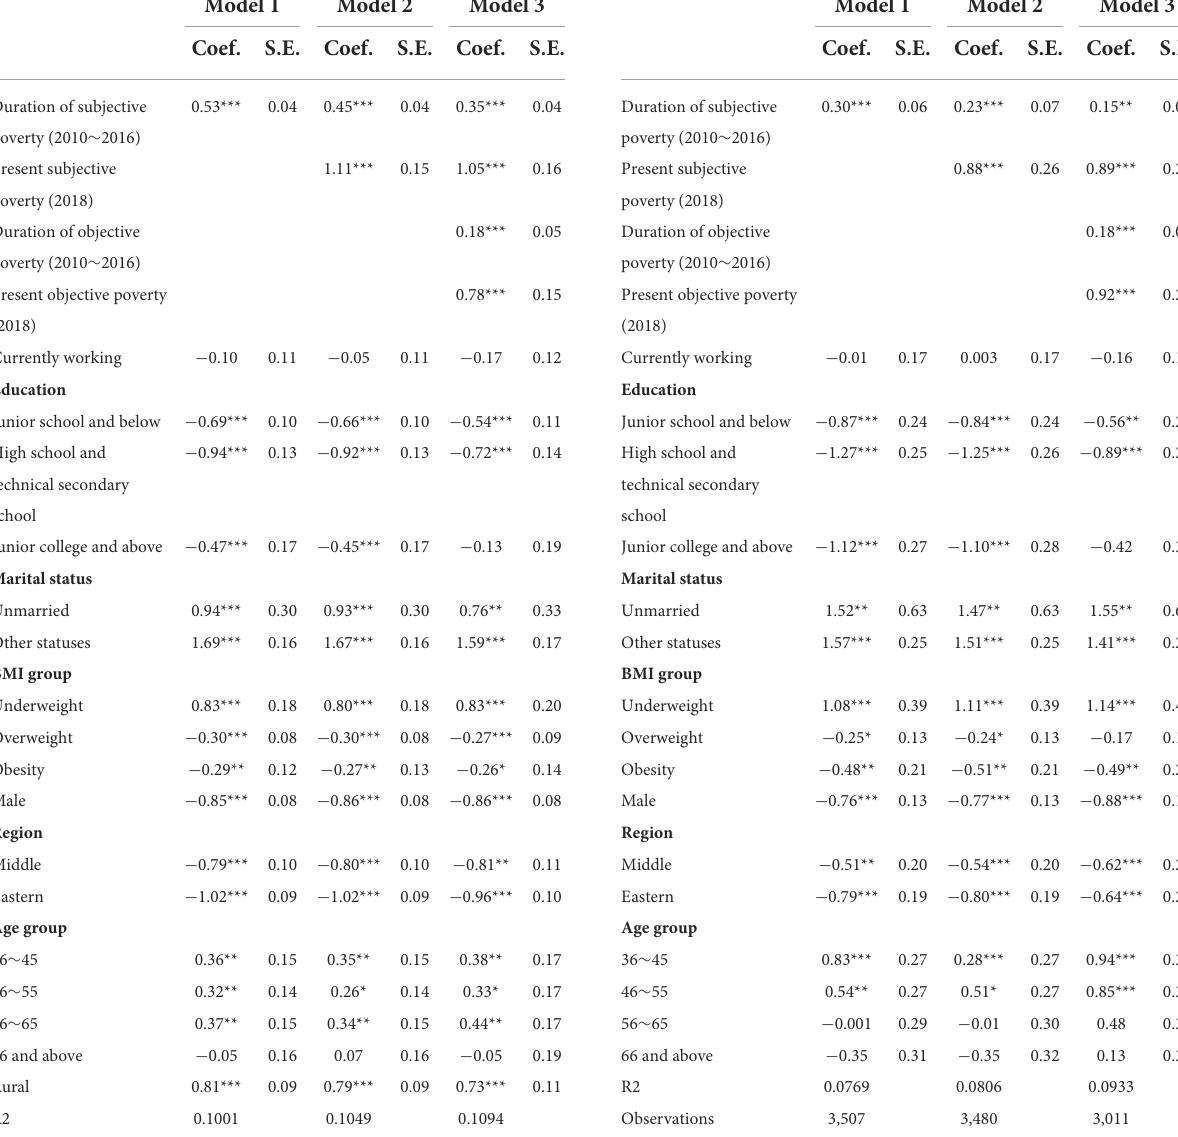
*,**,and***:significantlydifferentfromzeroatthe0.1,0.05,and0.01level,respectively.